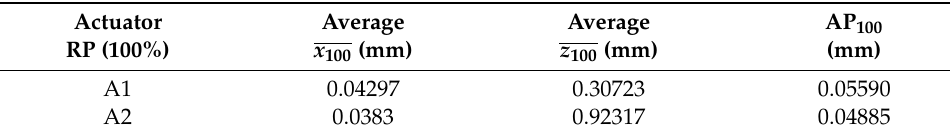
Figure 8. Plotted RP comparison under the full load. 5. Discussion When evaluating the measured and calculated AP data, it was found that when fully loaded, both actuators attained the average AP at the level comparable with half the load. The difference lay only in the range of the maximum and minimum values calculated. A significant difference in deviations in the beginning and at the end of the 30 measurements was attributed to unsatisfactory heat dissipation. Further investigation confirmed that the addition of cooling substantially reduced the differences between the first and the last